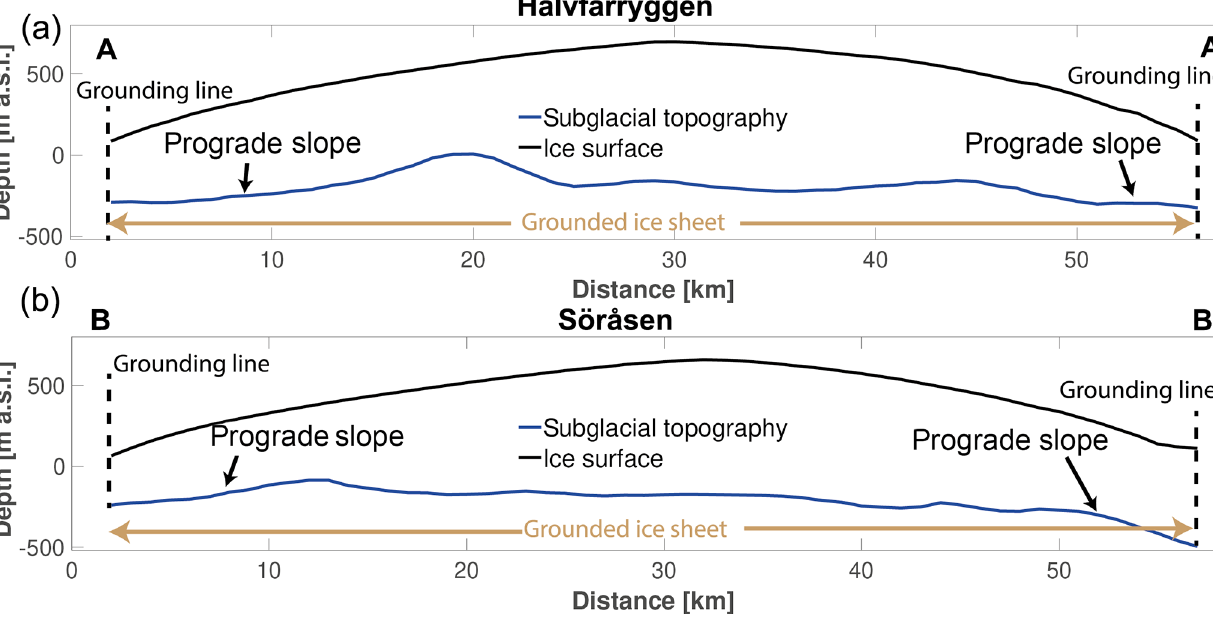
Figure 12. Cross sections of grounded subglacial topography from the BEDMAP2 dataset (Fretwell et al., 2013) for the (a) Halvfarryggen and (b) Söråsen ice rises, underlining the prograde sloping subglacial topography of both ice rises in the vicinity of the current grounding